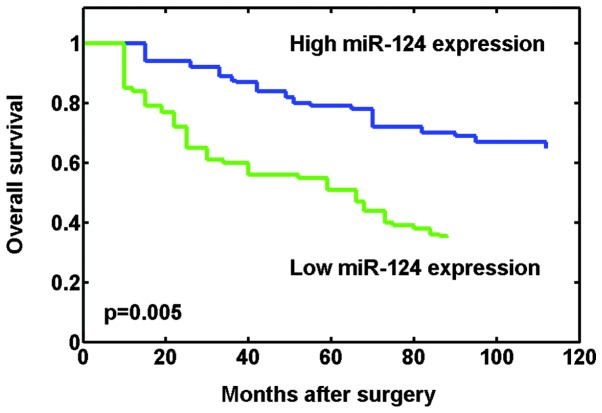
Overall survival curves for two groups defined by low and high expression of miR-124 in osteosarcoma patients. The patients with low miR-124 expression had a significantly shorter overall survival (P<0.001) than those with high miR-124 expression. miR-124, microRNA-124.